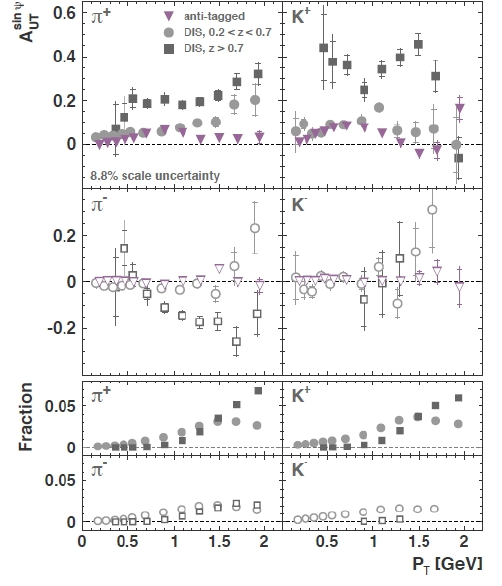
Figure 12. Hall A measurements of the Sivers asymmetries on neutrons for π ± (left) and K ±